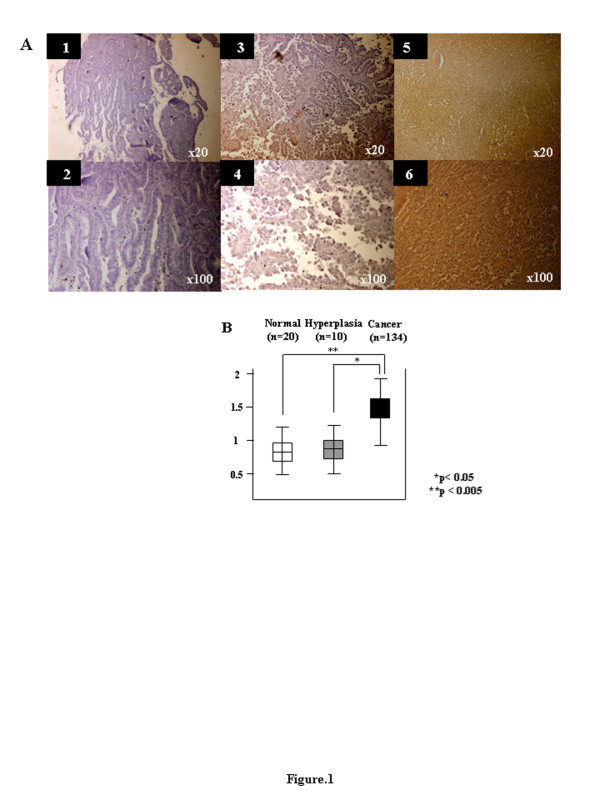
Representative immunostaining patterns of emmprin. A) 1. Weak epithelial cell staining (original magnification x20). 2. Weak epithelial cell staining (original magnification x100) (Grade 1 endometrioid adenocarcinoma). 3. Moderate epithelial cell staining (original magnification x20). 4. Moderate epithelial cell staining (original magnification x100) (Grade 2 endometrioid adenocarcinoma). 5. Strong epithelial cell staining (original magnification x20). 6. Strong epithelial cell staining (original magnification x100) (Grade 3 endometrioid adenocarcinoma). B) Histograms of emmprin expression according to the specimens (uterine normal endometrium, endometrial hyperplasia and endometrial cancer).